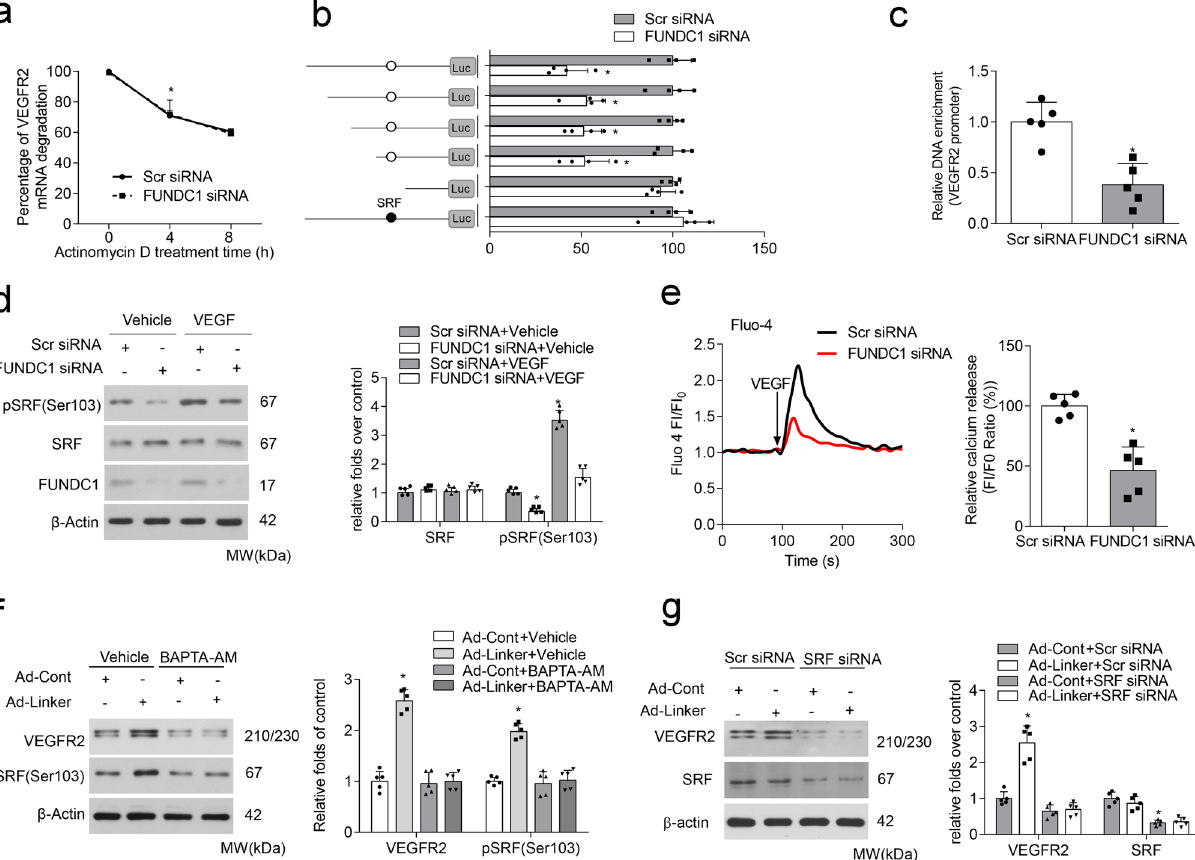
Fig. 5 SRF mediates the positive regulation of MAMs on VEGFR2 expression. a HUVECs were pre-transfected with or without FUNDC1 siRNA for 24 h, then treated with actinomycin D for different periods of time. RT-qPCR assay analysis of vascular endothelial growth factor receptor 2 (VEGFR2) mRNA levels ( n = 5 independent experiments). b HUVECs were pre-transfected with or without FUNDC1 siRNA for 24 h, then transfected with various VEGFR2 promoter truncation constructs or a mutant (serum response factor [SRF] binding site) construct for 24 h. After this, luciferase activity was measured ( n = 5 independent experiments). c Chromatin immunoprecipitation assays using an anti-SRF antibody to amplify VEGFR2 promoter in HUVECs transfected with or without FUNDC1 siRNA ( n = 5 independent experiments). d HUVECs were pre-transfected with or without FUNDC1 siRNA for 24 h and then treated with VEGF for 30 min. Expression of SRF and phosphorylated SRF at Ser103 (pSRF) was determined by western blot assay ( n = 5 independent experiments). e Cytosolic Ca 2 + levels, as indicated by the fl uorescent probe Fluo-4, AM ( n = 5 independent experiments). HUVECs were transfected with